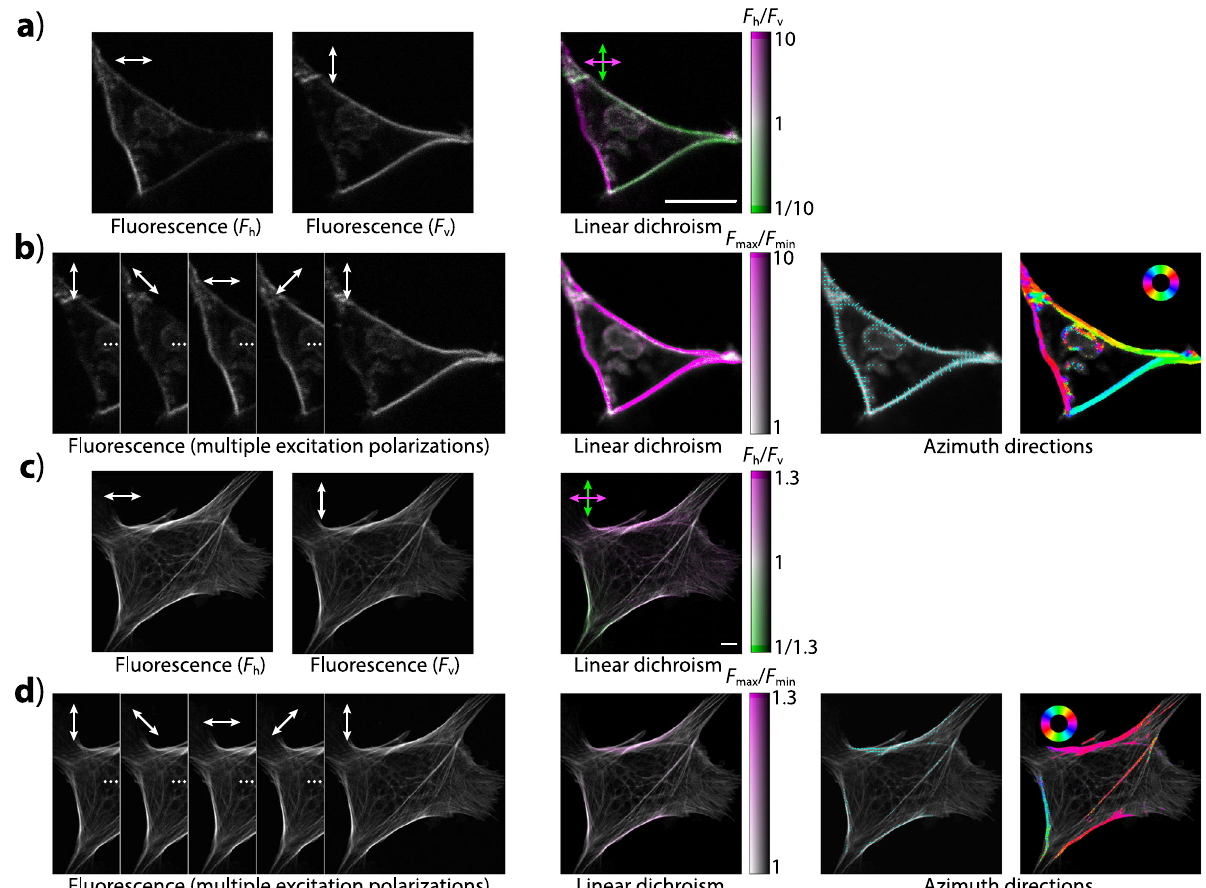
Fig. 2 LD visualization. a Images of a cell expressing a membrane-localized fl uorescent protein construct (dlmeGFP), observed using 2P excitation light polarized horizontally and vertically. Left: unprocessed images; Right: after processing, visualizing fl uorescence intensity as brightness and the extent of LD ( r ) as hue (indicated by the color bar). b Images of the cell in ( a ), but acquired with multiple polarizations of the excitation light, before and after processing. Brightness indicates fl uorescence intensity; hue indicates LD ( r max ), as shown by the color bar. Azimuth directions are shown as directed lines or by color (as shown by a color wheel). c , d Similar to ( a ), ( b ), but a cell with micro fi laments stained with Texas Red/phalloidin, showing only a subtle LD. Scale bars: 20 µ